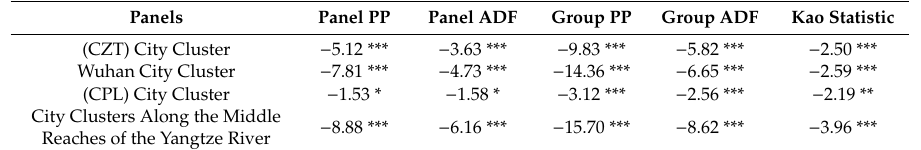
Table 2. Results of the cointegration test. PP: Phillips-Perron and ADF: Augmented Dickey-Fuller. Panels